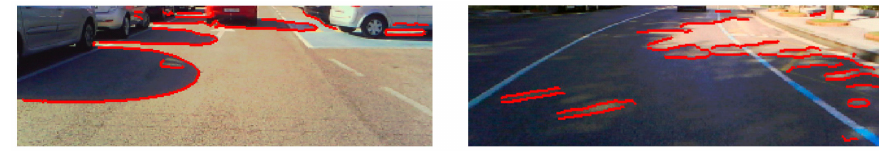
Figure 4. Shadow edge detection obtained by the three constraints in Property